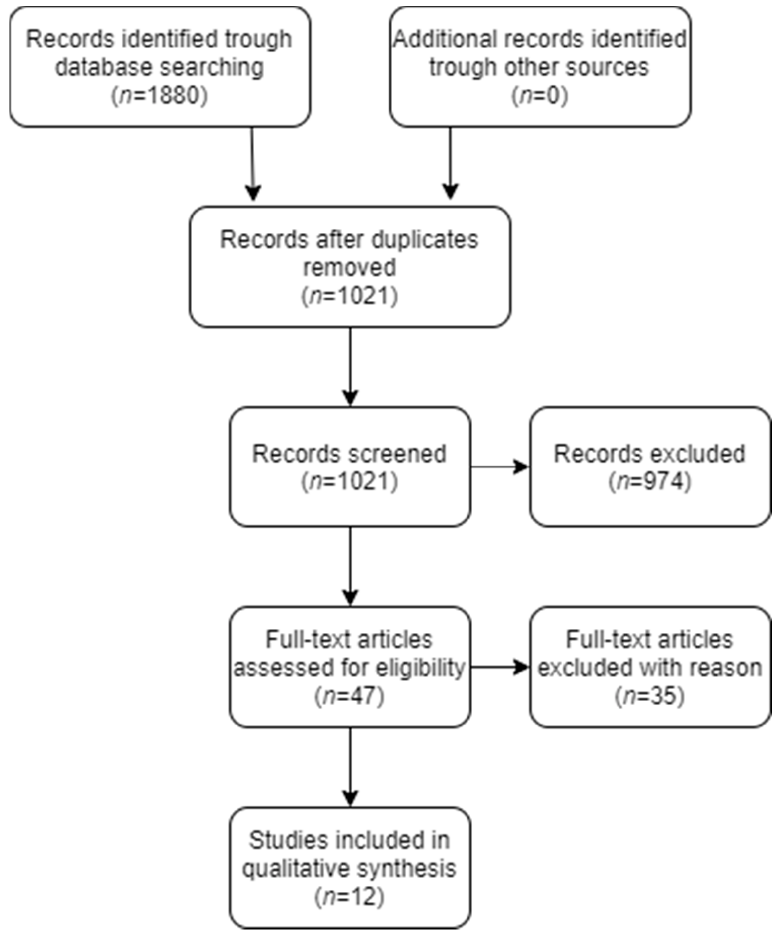
Figure 1. Preferred reporting of systematic reviews and meta-analyses (PRISMA) flow diagram related to bibliographic searching and study selection.